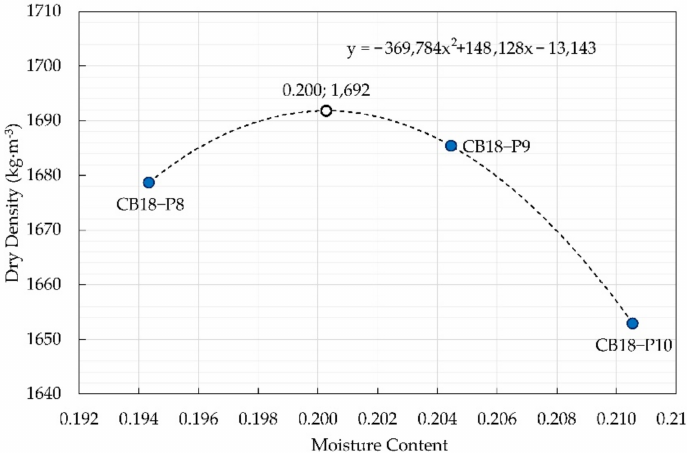
Figure 12. Relative maximum dry density and optimal moisture content (white dot) for mixtures with 18% bentonite